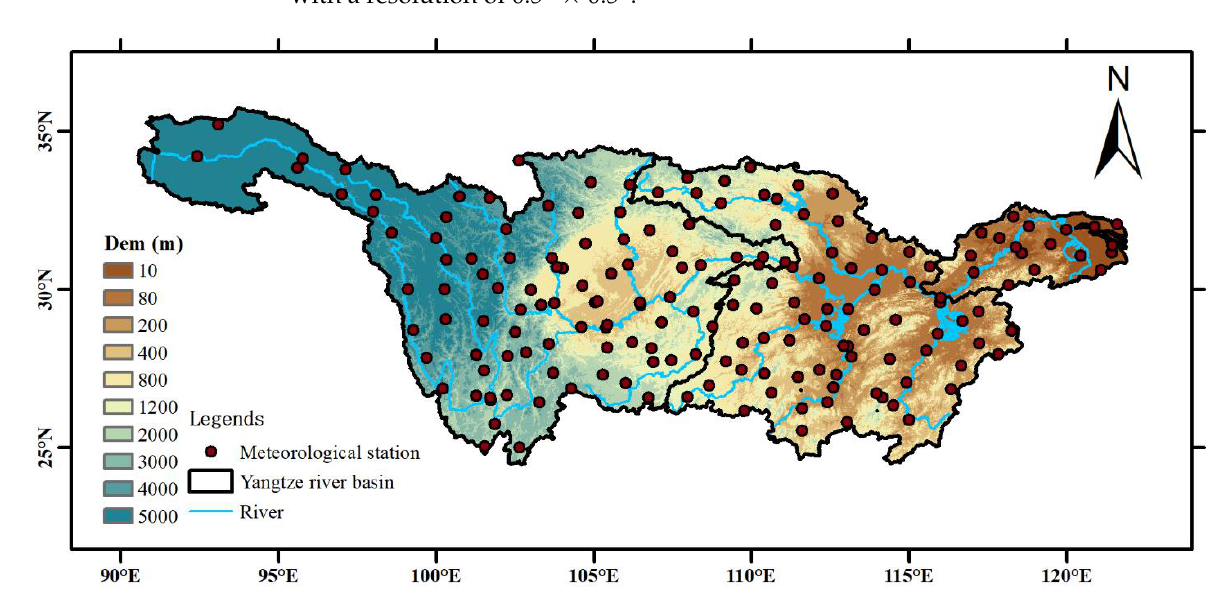
Figure 1. Topographic map of the Yangtze River basin (Dem refers to Digital Elevation Model). The sub-basins from left to right are the upper, middle, and lower reaches, respectively. Table 1. Information on the 19 CMIP6 climate models used in this